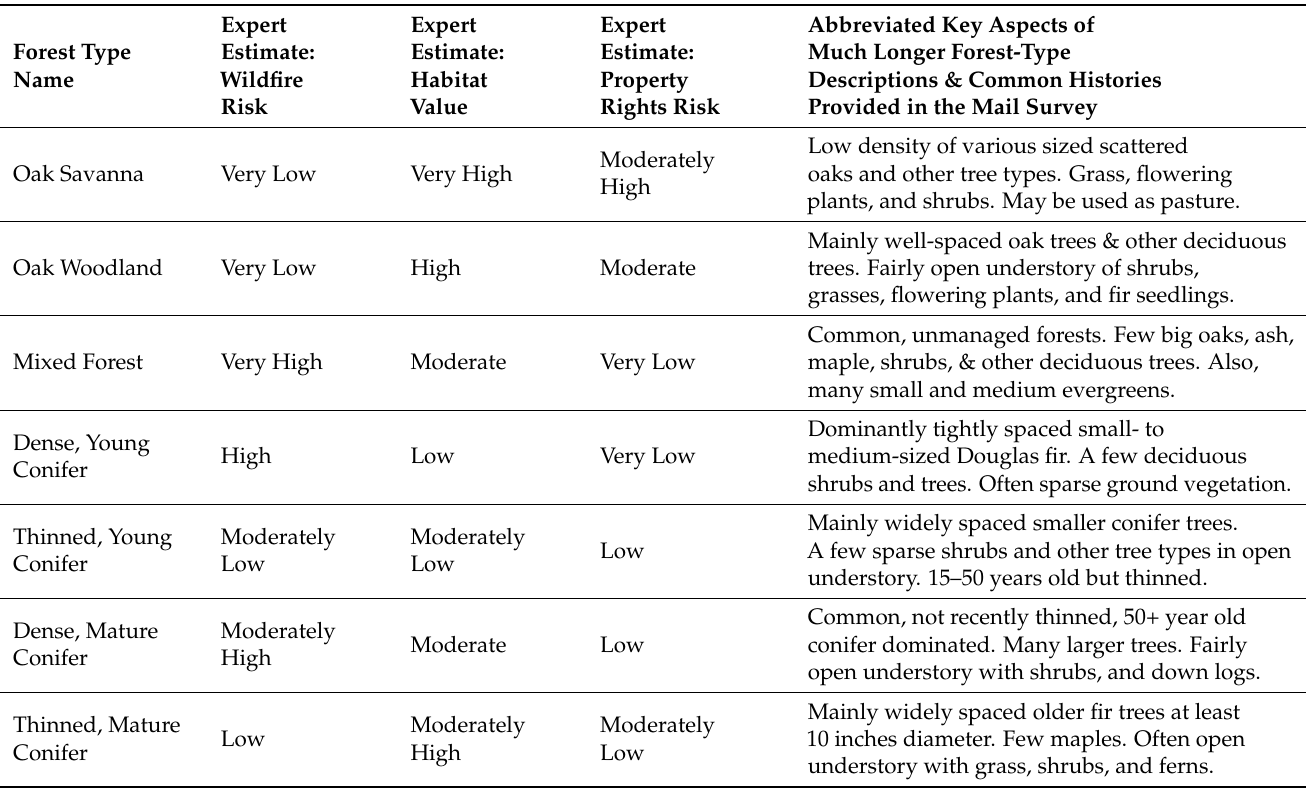
Table 1. Broadly defined forest types used in the